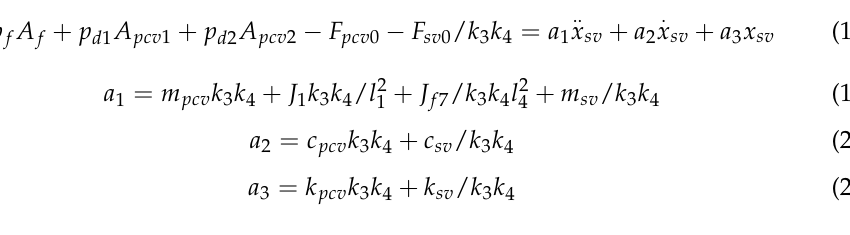
the moment of inertia of feedback fork around O 7 ; k 3 = l 1 / l 2 , k 4 = l 3 / l 4 , l 1 is the distance be- tween O 1 and O 6 ; l 2 is the distance between O 1 and O 4 ; l 3 is the distance between O 4 and O 7 ; l 4 is the distance between O 3 and O 7 ; c pcv is the damping coefficient of the power control valve; c sv is the damping coefficient of the servo valve; k sv is the spring stiffness of the servo valve; and k pcv is the spring stiffness of the power control valve.